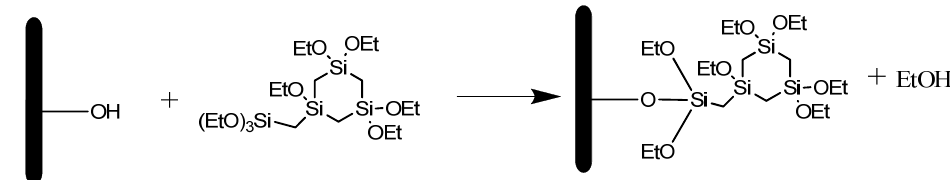
Figure 1. Grafting cyclic bridged organosilane precursor on